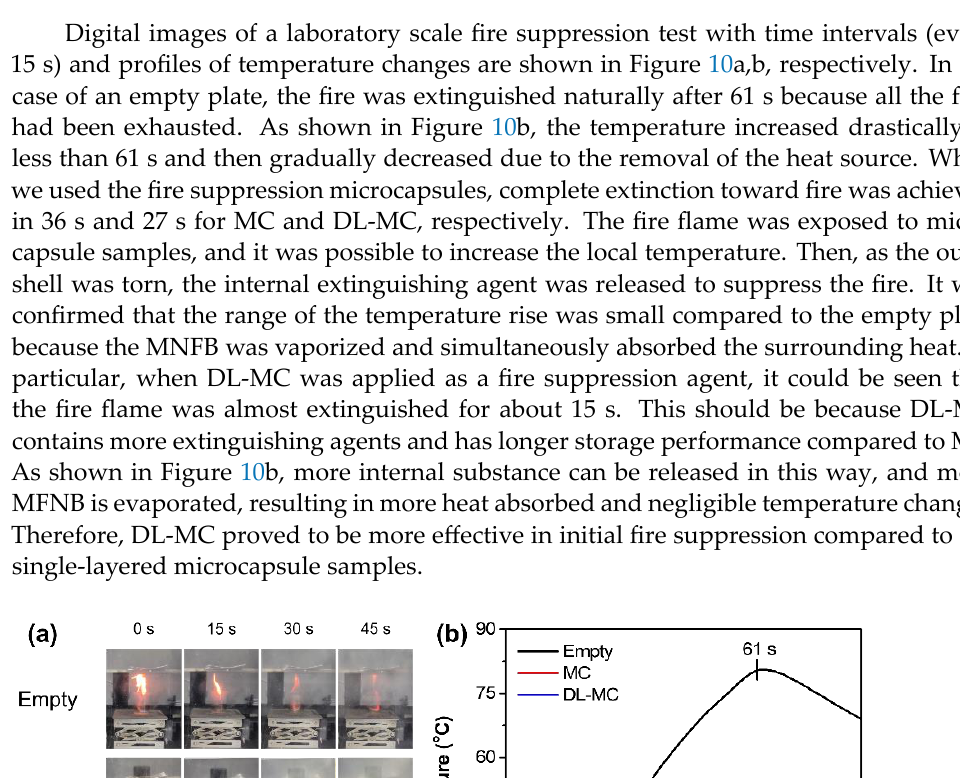
Figure 9. Schematic diagram of the fire suppression test on a laboratory scale.